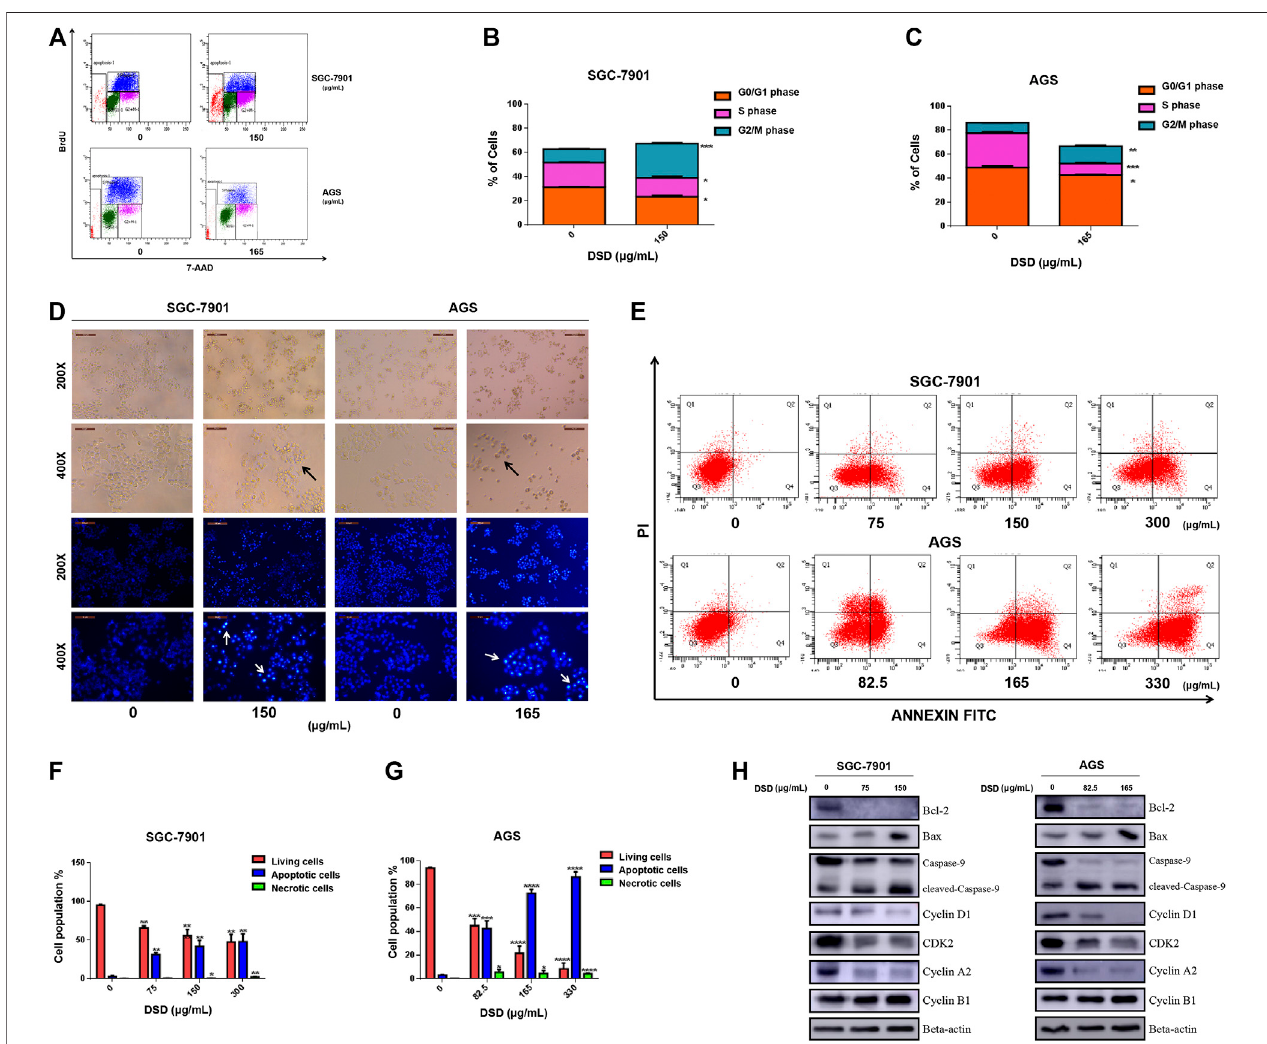
FIGURE6| DSDtreatmentresultedindisturbance ofcellcycleprogressionandapoptosisinGCcells. (A) CellcycleanalysisofGCcellsfollowingDSDtreatmentin SGC-7901 (0 and 150 μ g/ml) and AGS (0 and 165 μ g/ml) for 24 h by fl ow cytometry. (B,C) Statistical analysis of the proportions of the cells at different phases in SGC- 7901andAGScells.** p < 0.01basedontheStudent t -test. (D) Bothcells ’ morphologywereobservedinwhitelightand fl uorescence fi eldusinganinvertedmicroscope. (E) Induction of apoptosis of SGC-7901 and AGS cells after DSD treatment. SGC-7901 cells were treated with DSD at different concentrations (0, 75, 150, and 300 μ g/ml) for 24 h, and AGS cells were also treated with DSD at different concentrations (0, 82.5, 165, and 330 μ g/ml) for 24 h, when apoptotic events was assessed by fl ow cytometry. (F,G) Statisticalanalysisofthepercentagesoftheapoptotic cellsin SGC-7901 and AGScells. ** p < 0.01 based onthe Student t -test. (H) SGC-7901 (0, 75, and 150 μ g/ml) and AGS (0, 82.5 and 165 μ g/ml) cells were treated with DSD at different concentrations for 24 h. After proteins were extracted, the expression levels of Bcl-2, Bax, pro-caspase-9, cleaved-caspase-9, Cyclin D1, CDK 2, Cyclin A2 and Cyclin B1 were analyzed by Western Blot assay.